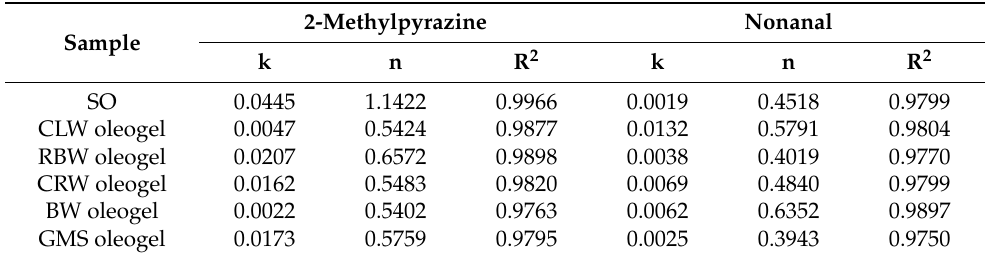
Table 3. Fitting results of Weibull equations of 2-methylpyrazine and nonanal in different